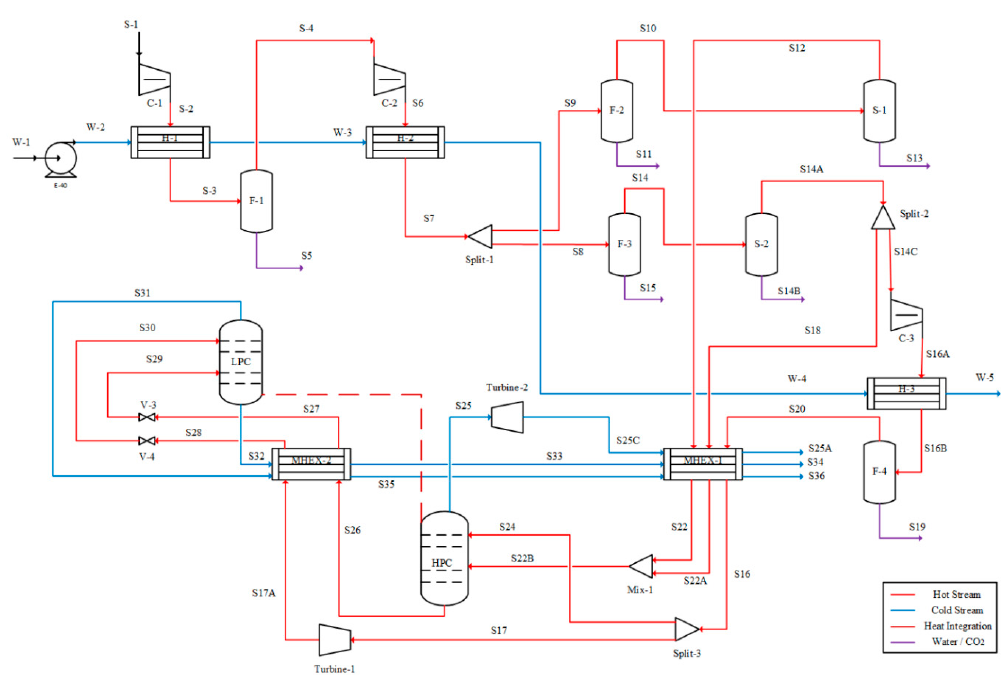
Figure 6. Process flow diagram of the ASU configuration C6. Table 7. Steady-state simulation results for the ASU configuration C7.